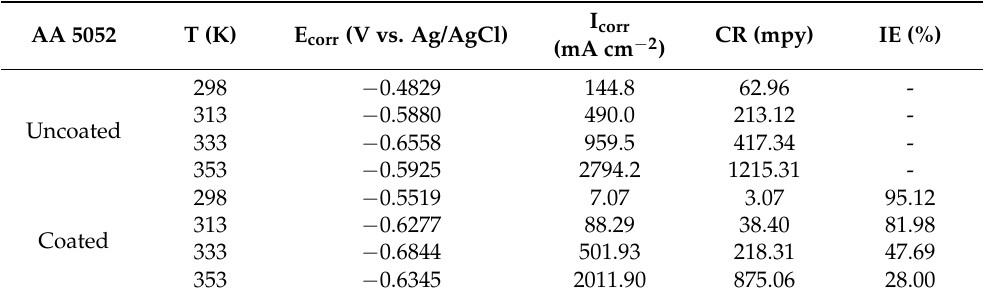
Table 4. Tafel of potentiodynamic polarization for AA5052 coated Chitosan (EPD Time 20 min and uncoated in 0.5 M H 2 SO 4 at 298, 313, 333, and 353